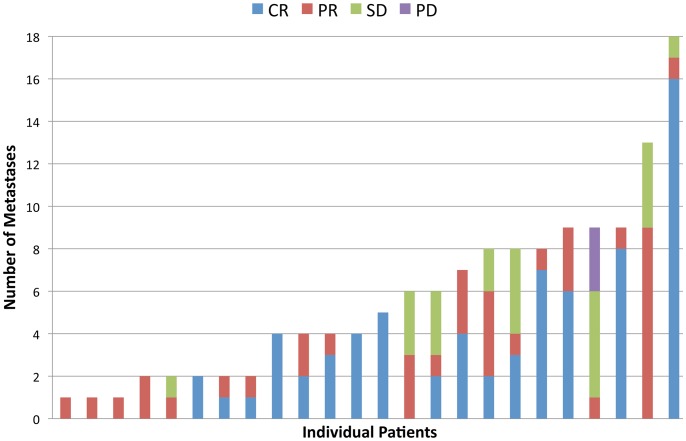
The best response of each individual metastasis within each patient.Abbrevations: CR, complete response; PR, partial response; SD, stable disease; PD, progressive disease.